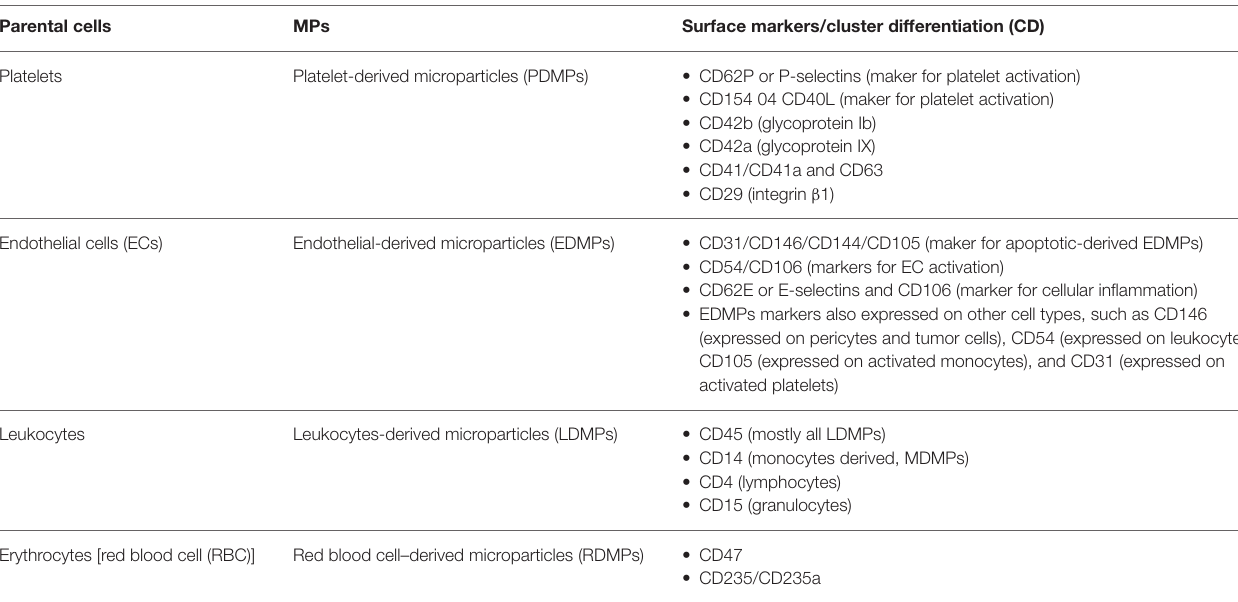
TABLE 2 | Microparticles (MPs) subpopulation and their surface markers. Parental